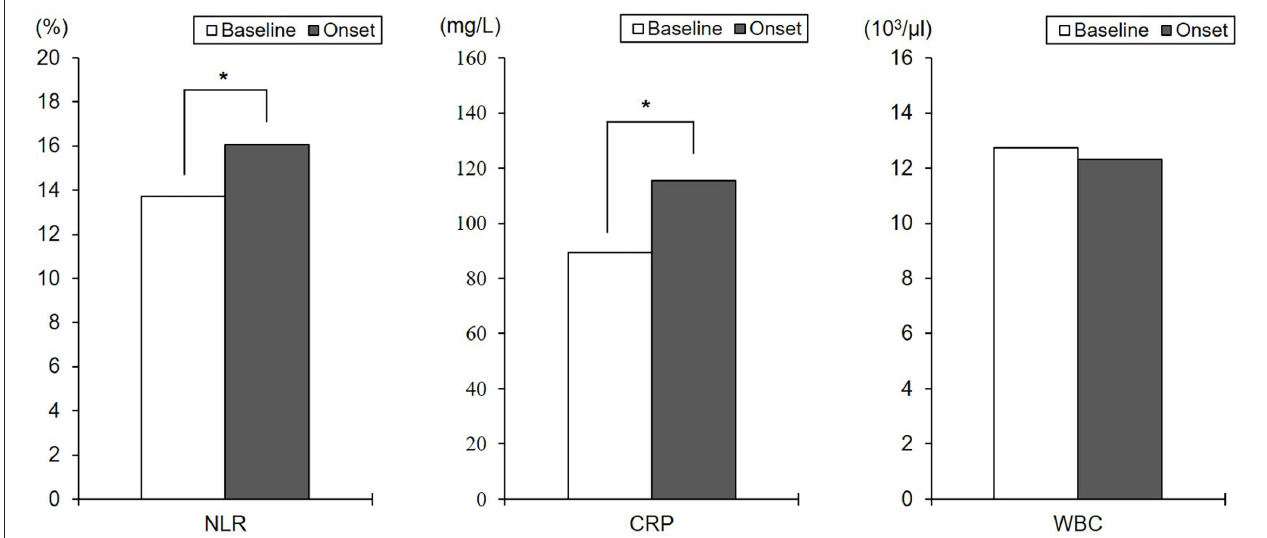
FIGURE 2 | Differences between baseline and delirium onset among inflammatory markers. * p < 0.001. Baseline, the initial day of intensive care unit admission; Onset, the initial day of delirium onset; NLR, neutrophil-lymphocyte ratio; CRP, C-reactive protein; WBC, white blood cell.